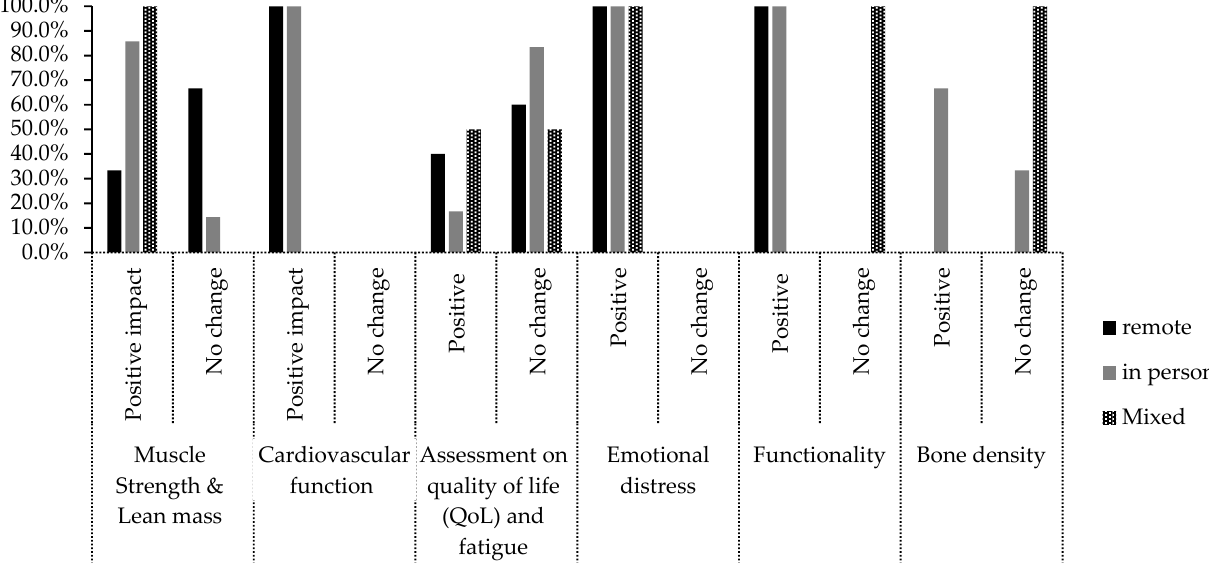
Figure 4. Patient outcomes displayed as percent (%) by trial delivery for: muscle strength, cardiovas- cular function, QoL, emotional distress, functionality and bone